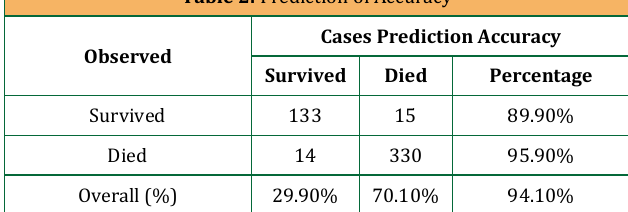
Table 2: Prediction of